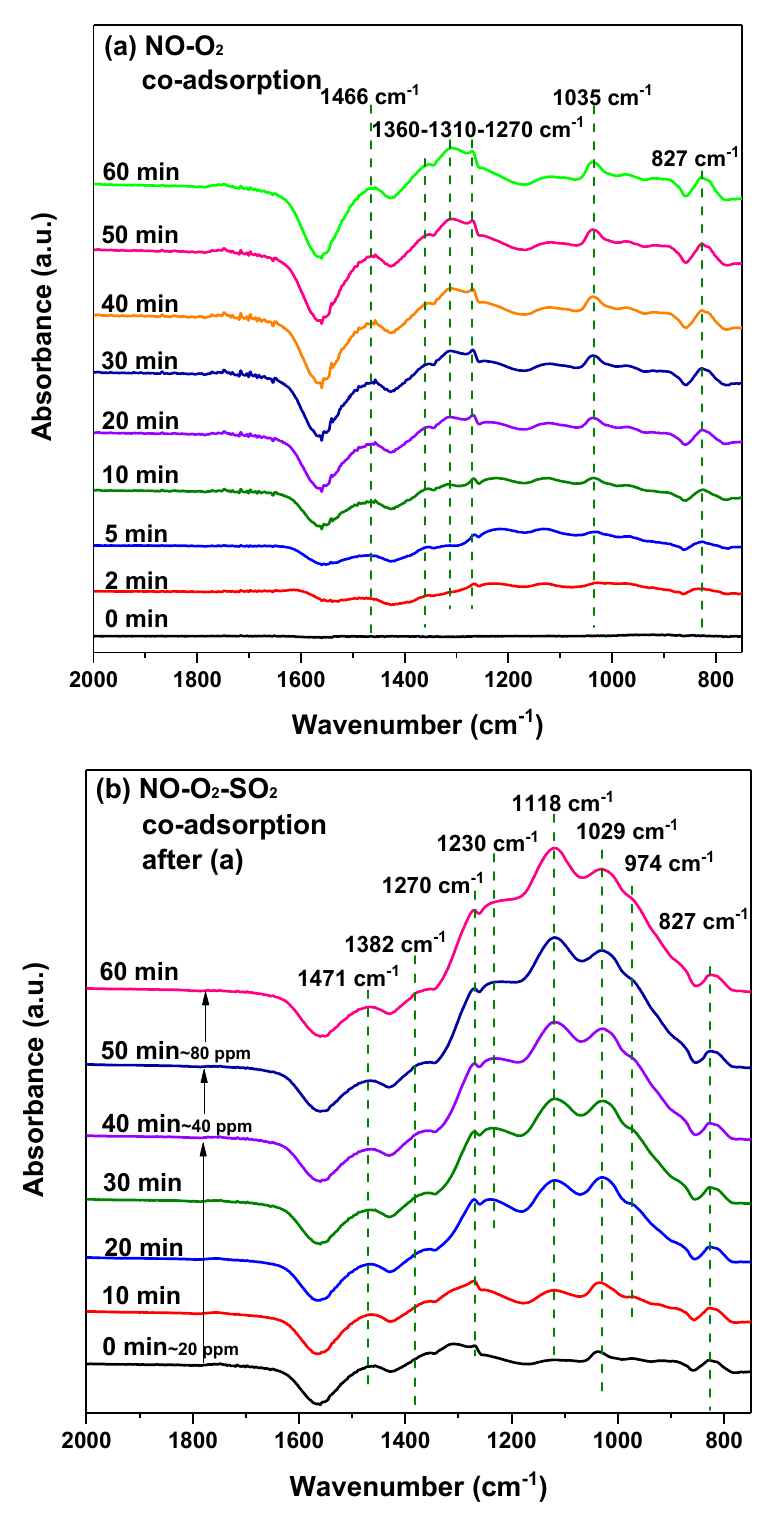
Figure 9. In-situ DRIFTS spectra of MnCeFe during NO–O 2 co-adsorption (( a ) 200 ppm NO–10% O 2 , N 2 balance and ( b ) 20~40~80 ppm SO 2 addition).